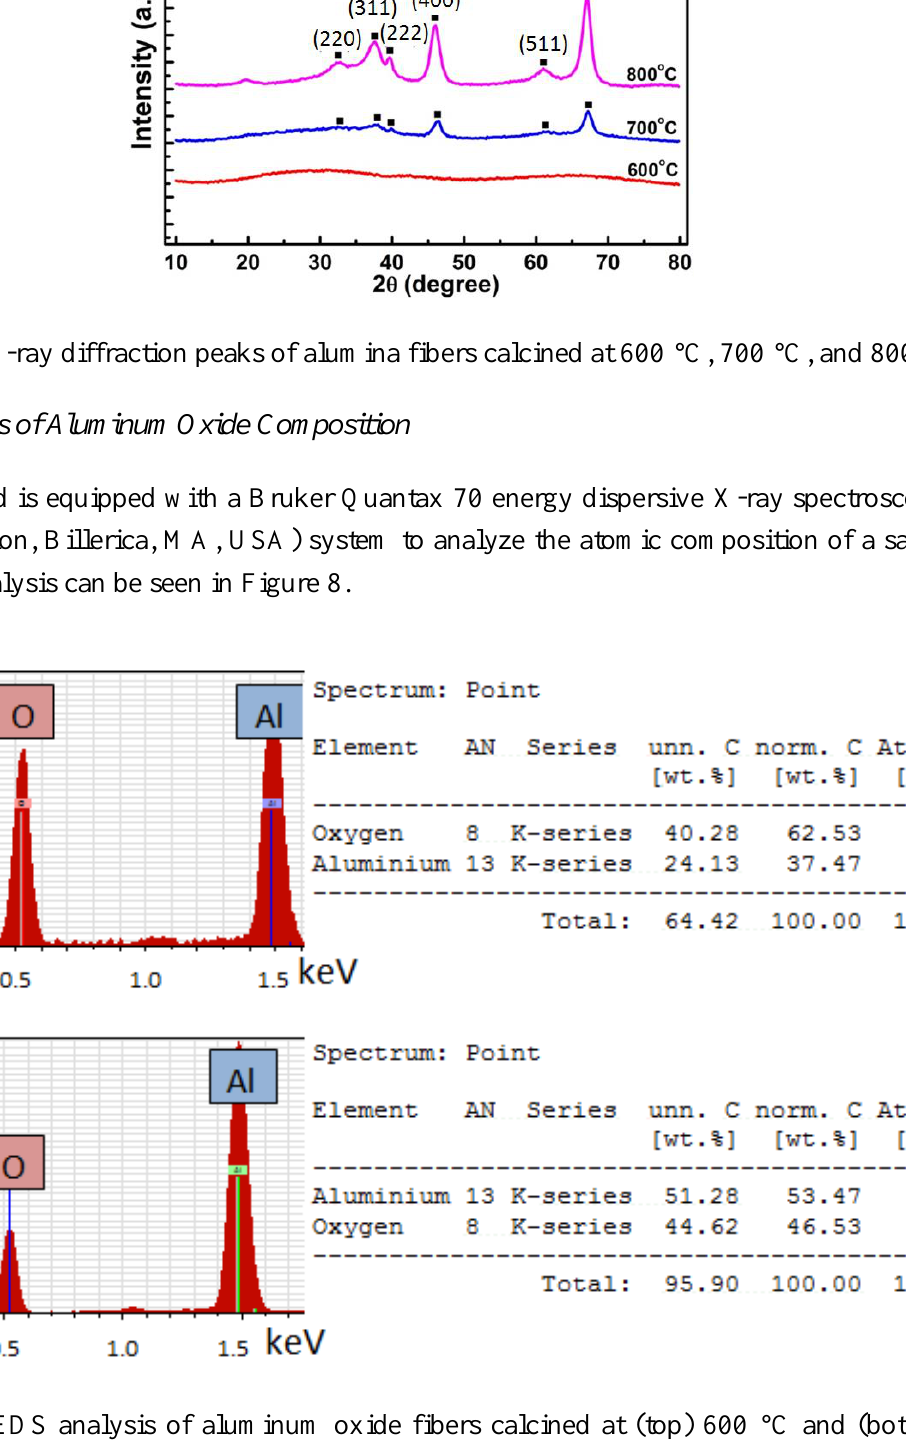
Figure 8. EDS analysis of aluminum oxide fibers calcined at (top) 600 °C and (bottom) 800